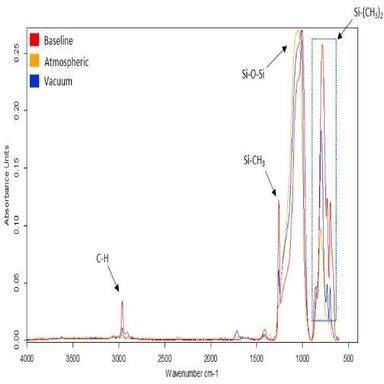
Ftir data of baseline, atmospheric, and vacuum silicone rubber.